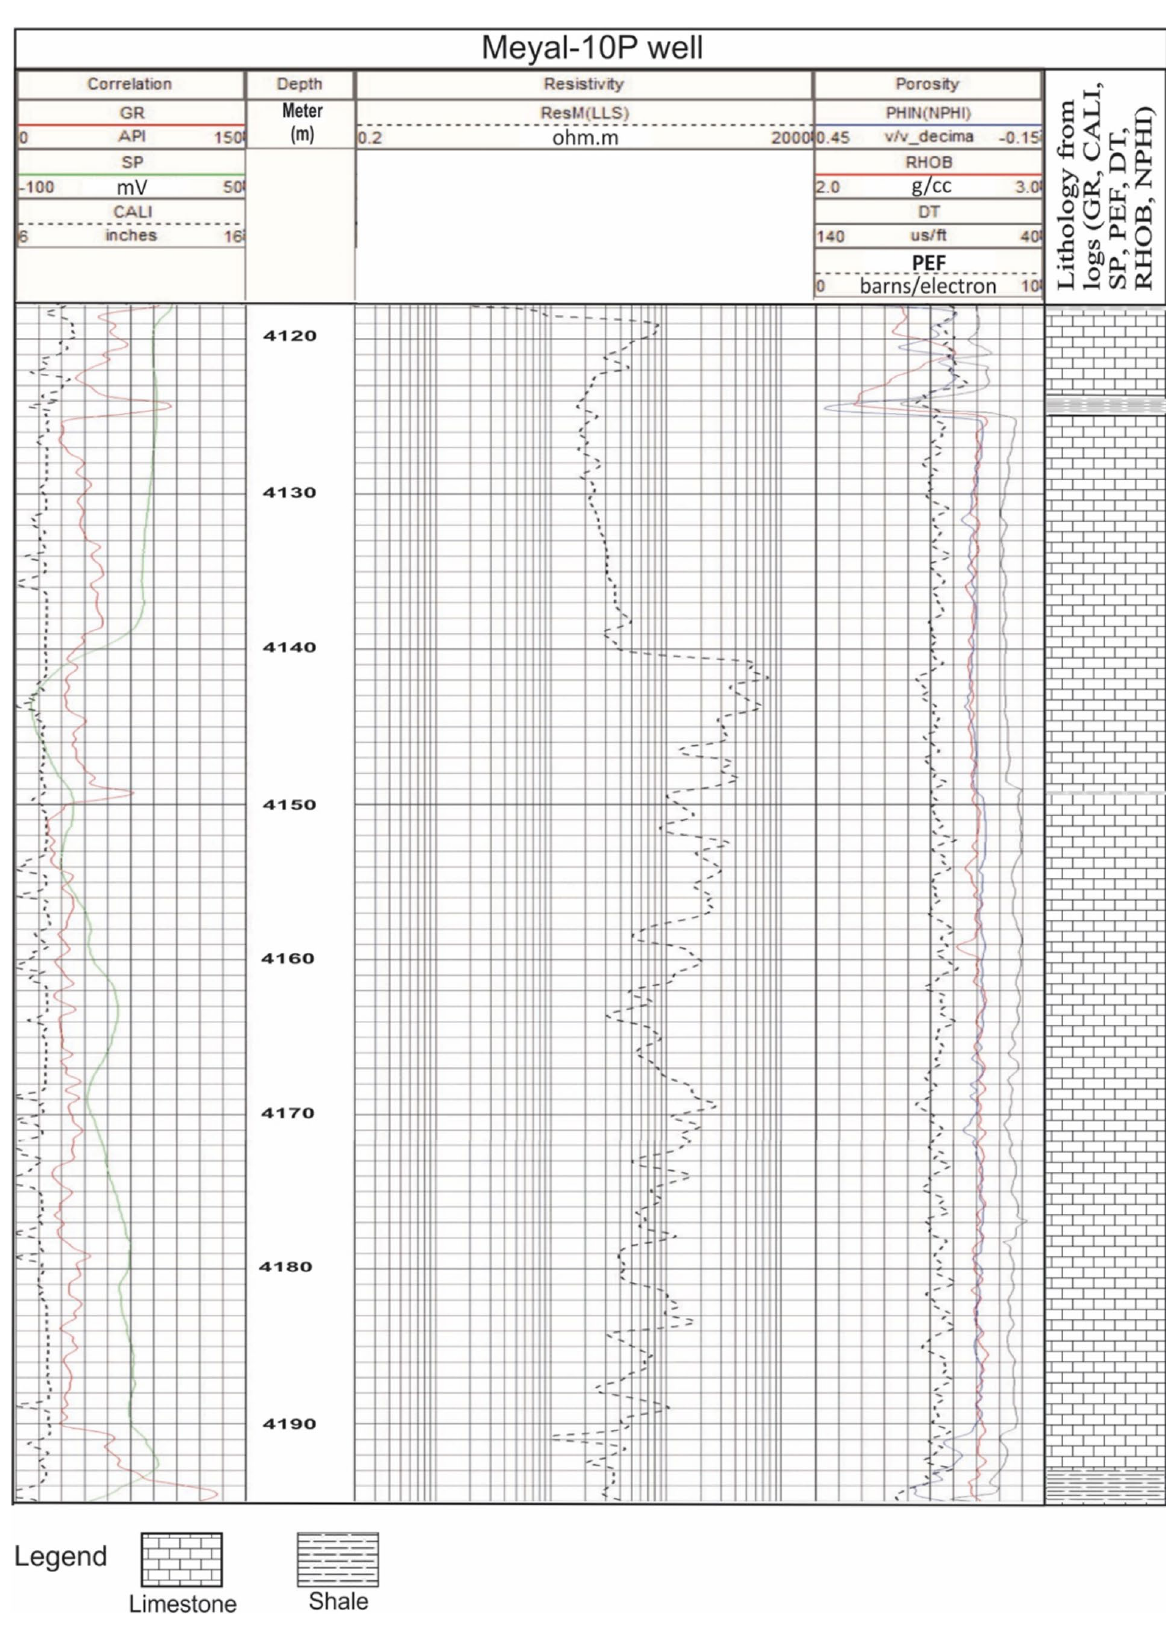
Fig. 17 Lithology interpretation of the Lockhart Limestone of Meyal-10P from petrophysical